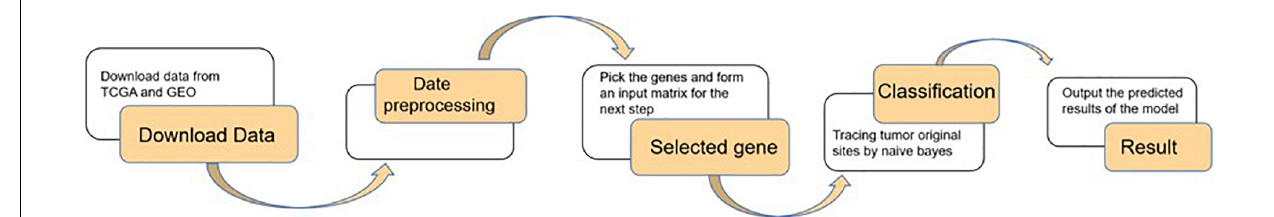
FIGURE 1 | Flow chart of the article.